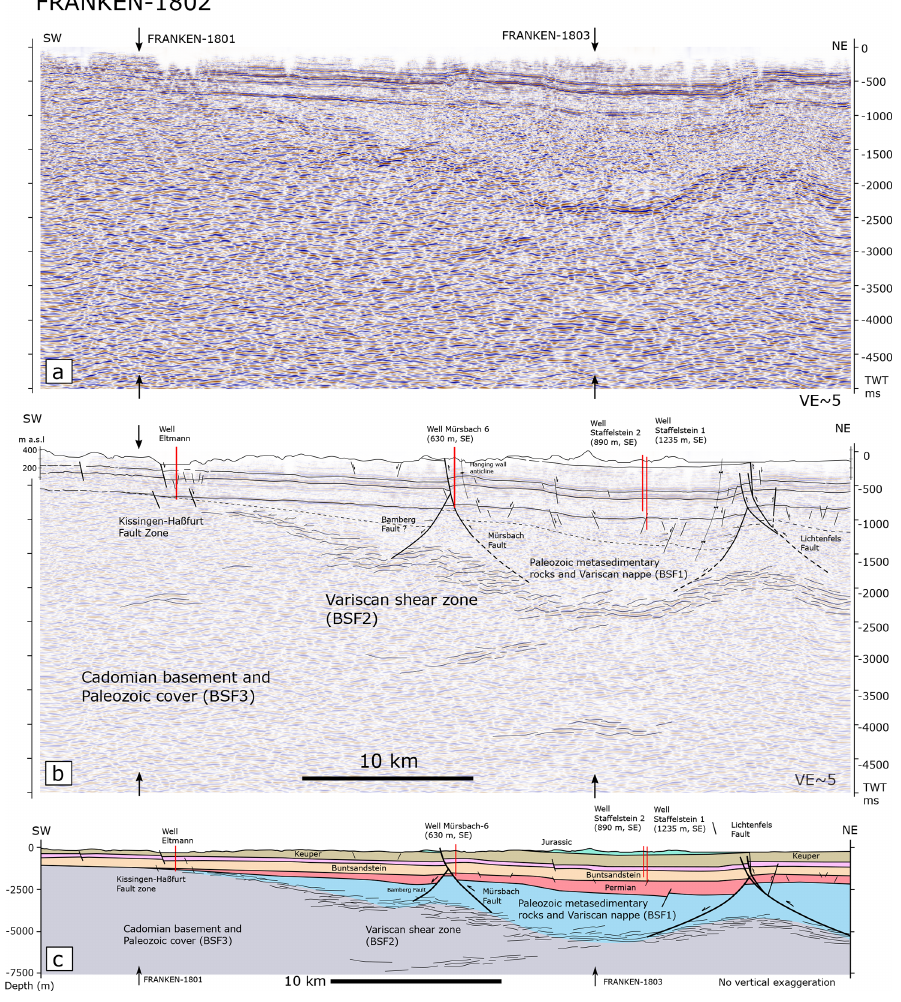
Figure 7. The FRANKEN-1802 profile strikes NE–SW, perpendicular to the main structures. (a) Uninterpreted and (b) interpreted seismic profile. FRANKEN-1802 is tied to the Eltmann, Mürsbach, and Staffelstein 1 and 2 wells. High-amplitude and continuous reflection of BSF2 interpreted as Variscan shear zones are at 2000–2500ms TWT (5–6.5km) in the NE and reach to the base of Permian sedimentary rocks to the SE. Vertical exaggeration is 5 × . (c) Depth-converted section with no vertical exaggeration. See Fig. 1 for the profile